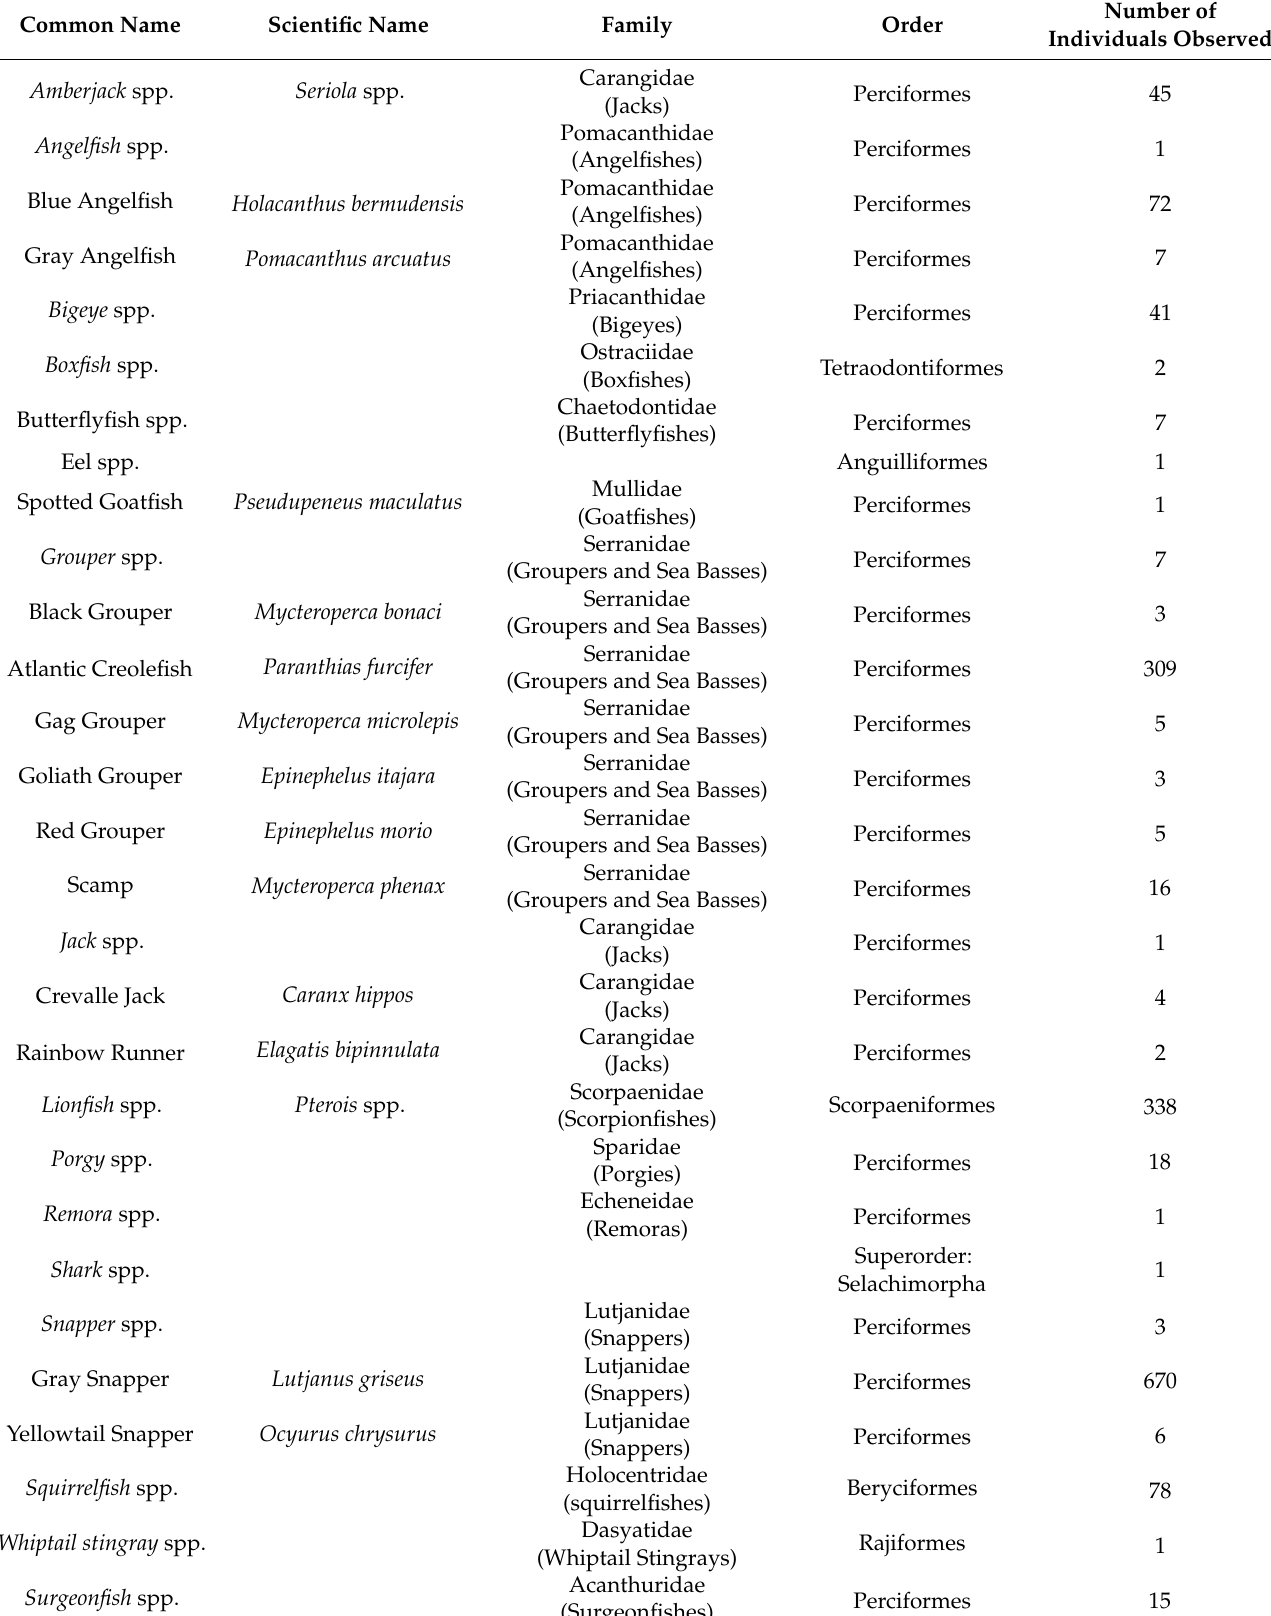
Table A2. List of all fish taxa observed along with the number of individuals